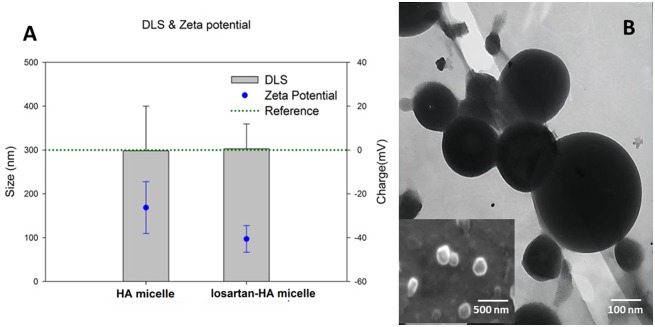
Physicochemical characteristics of HA micelle and losartan-HA micelle.
A. Size measurement by DLS and surface charge measurement by zeta potential of HA micelle and losartan-HA micelle in PBS at 7.4 pH. HA micelle and losartan-HA micelle was taken at 100 μg/ml concentration and bath sonicated (Power Sonic410,Hwashin,Korea) for 5 minutes at room temperature and measured; B. TEM image of a SPION loaded HA micelle and SEM image of losartan-HA micelle (inset). The size of losartan-HA micelle was estimated to be around 300nm based on SEM and DLS result whereas the morphology of particle was confirmed from TEM and SEM image.